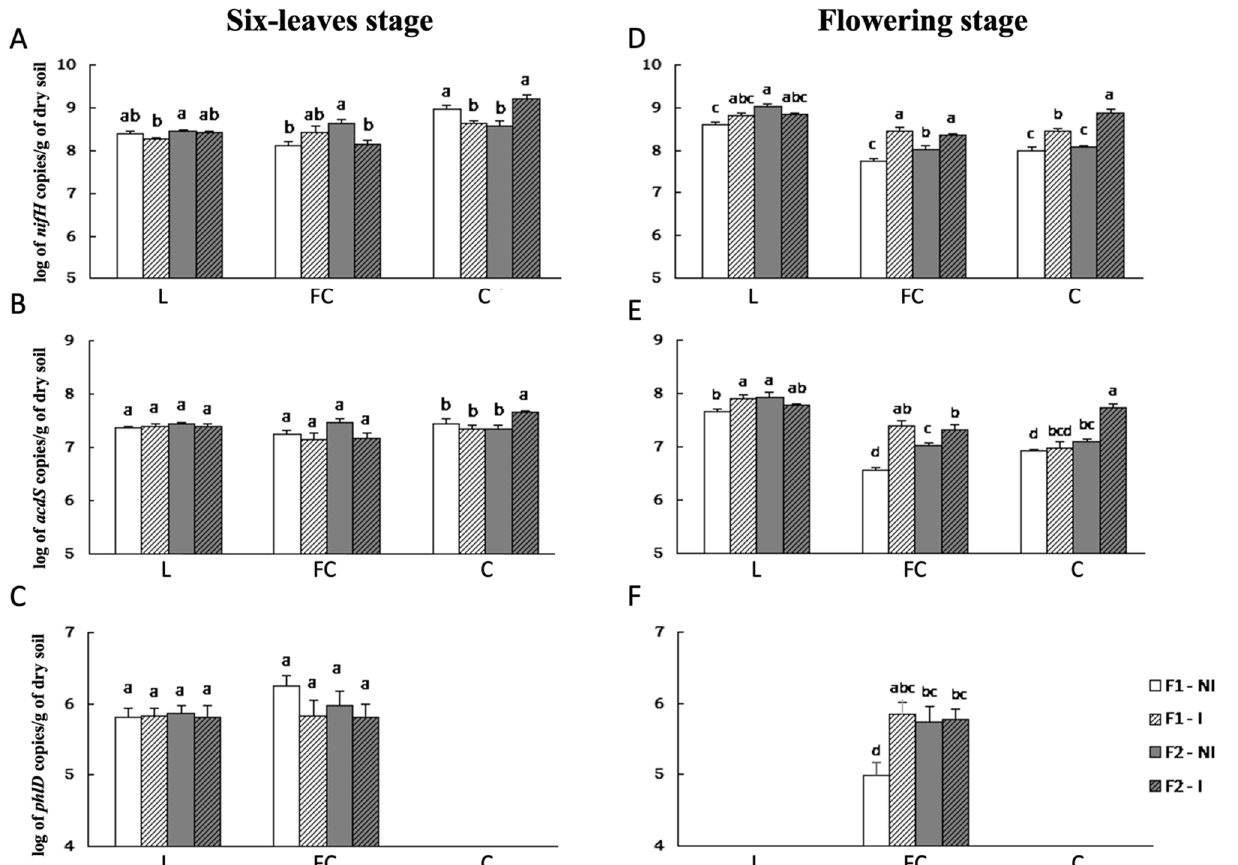
Figure 1. Effect of inoculation level of A. lipoferum CRT1 on the size of nifH ( A , D ) , acdS ( B , E ) and phlD ( C , F ) functional groups at two sampling times of maize in three fields. L, FC and C correspond to the three sites studied. Data are shown in log base 10, with standard errors ( n = 20). F1 corresponds to the peat matrix used to coat seeds with low inoculant concentration, and the data originate from [21]. In F2, A. lipoferum CRT1 was used at higher inoculant concentration. NI and I correspond, respectively, to non-inoculated and inoculated conditions. In C and F, some of the samples were below the detection threshold (3.2 × 10 3 phlD copies per gram of lyophilized soil). At each field site, statistical differences between the four treatments are indicated by letters a–d (ANOVA and Fischer’s LSD tests, p < 0.05).